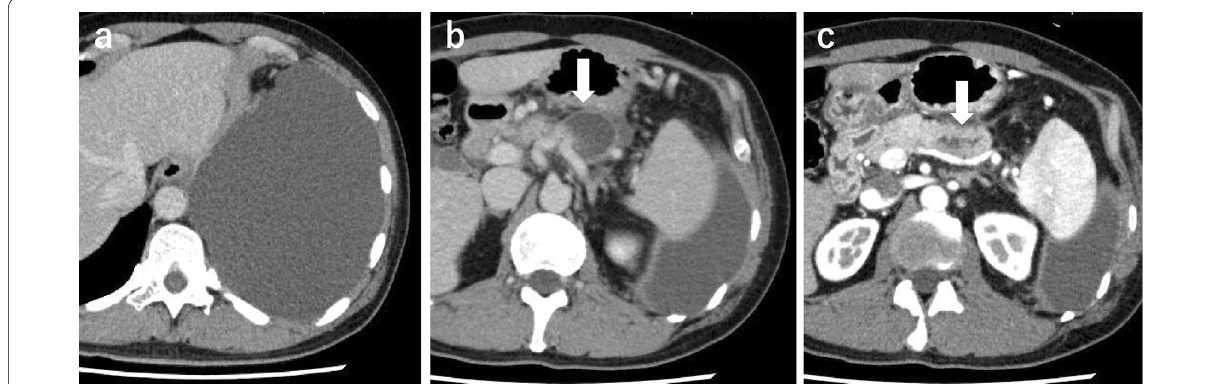
Fig. 1 Findings of computed tomography (CT). CT reveals left-sided pleural effusion ( a ). Pancreatic pleural effusion was diagnosed on pleural puncture, based on the high amylase content (36,854 IU/L) in the pleural fluid. b CT shows a pseudocyst (arrow). c Dilation of the main pancreatic duct (arrow) in the pancreatic tail. No tumor can be observed in the pancreas